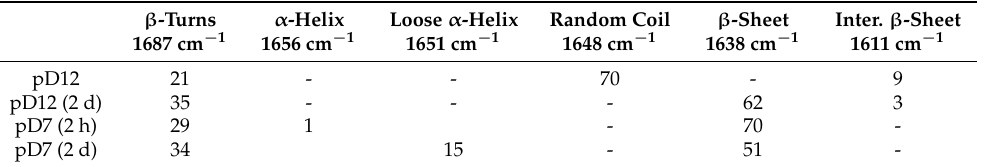
Table 2. Secondary structure of BSA–Au conjugate system in D 2 O estimated by deconvolution of amide I IR band (expressed in %, with the peak position of the component